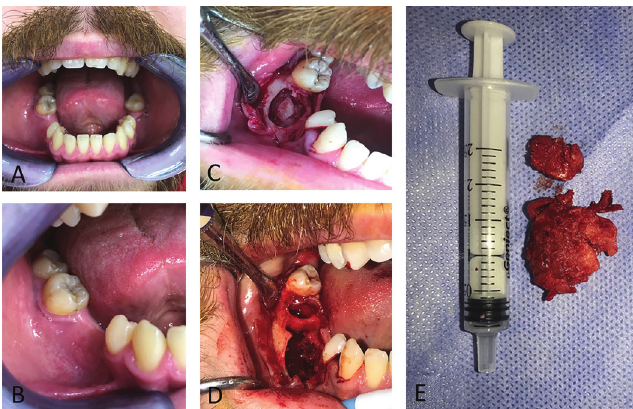
Figure 1 - Intraoral photograph before operation (A, B). Preparation of bone window (C). After removing the mass (D). Specimen (E).